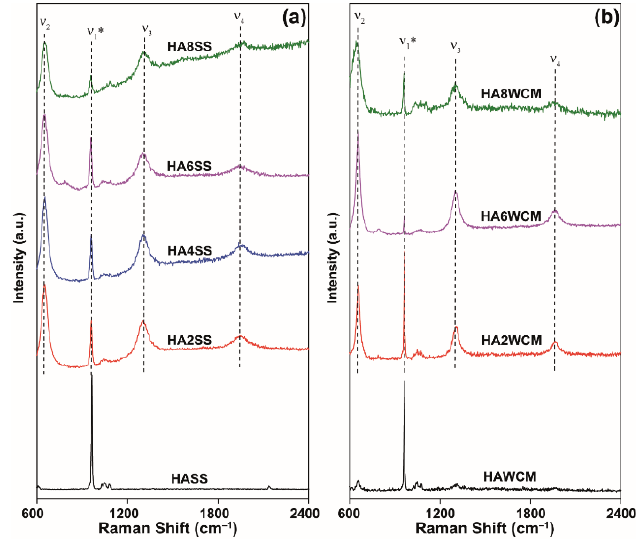
Figure 6. Raman spectra for cupriferous HA systems prepared by the ( a ) solid-state and ( b ) wet chemical synthesis routes.